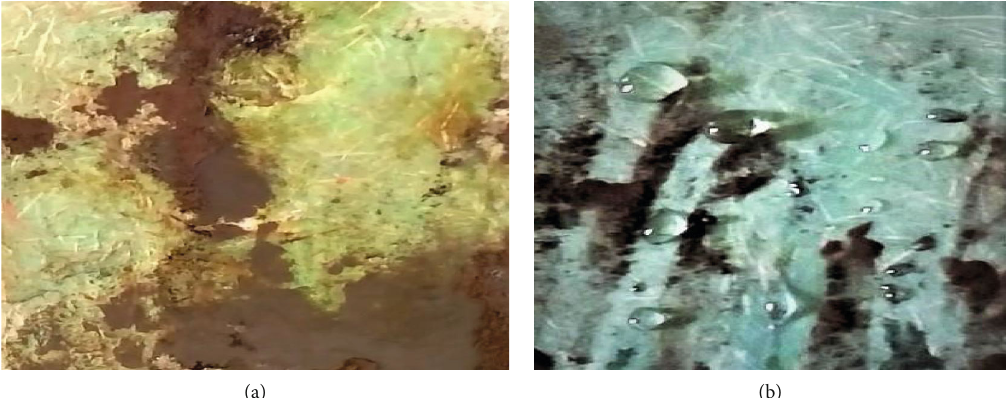
Figure 14: Self-cleaning properties of composite material (a) before surface modi fi cation and (b) after surface modi fi